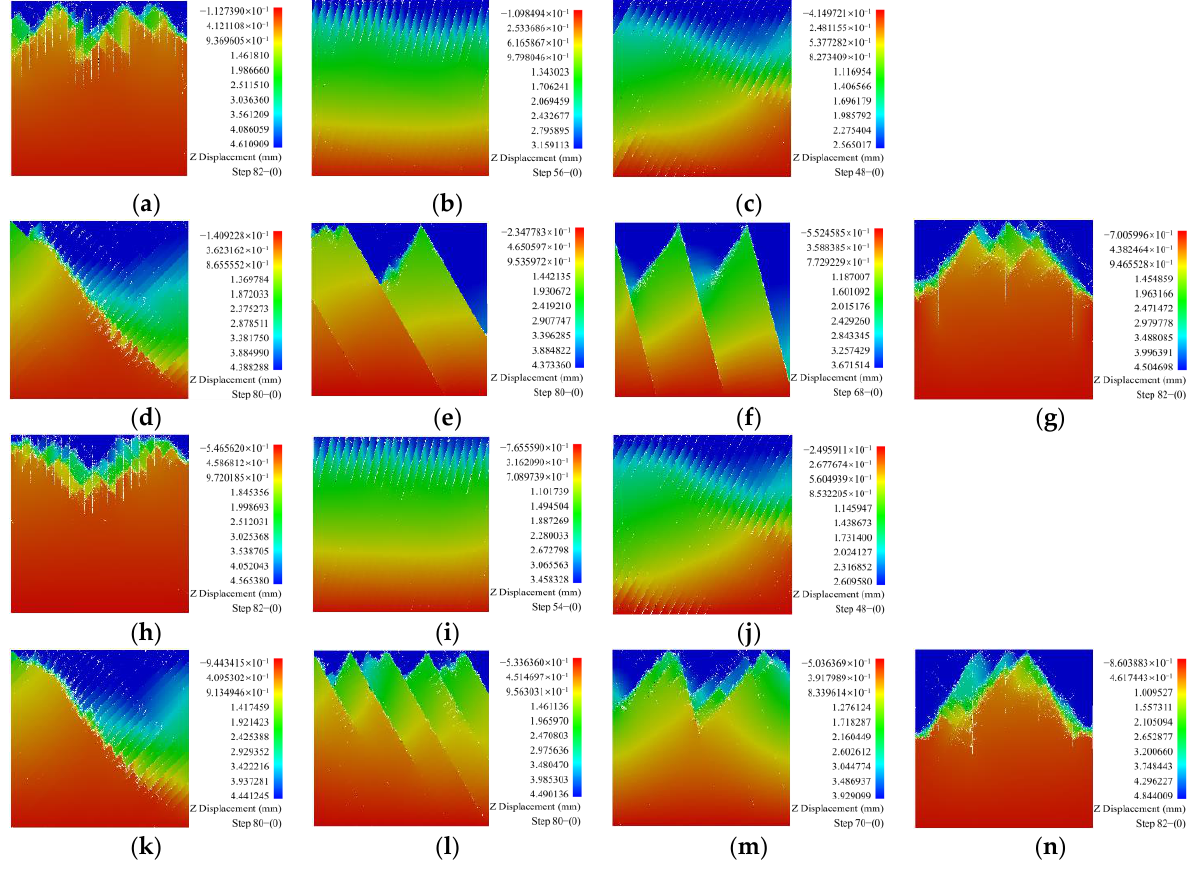
Figure 8. ( a – g ) The z-direction displacement diagrams of the CJBs with the joint distance ratio 0% and different column dip angles; ( h – n ) the z-direction displacement diagrams of the CJBs with the joint distance ratio 50% and different column dip